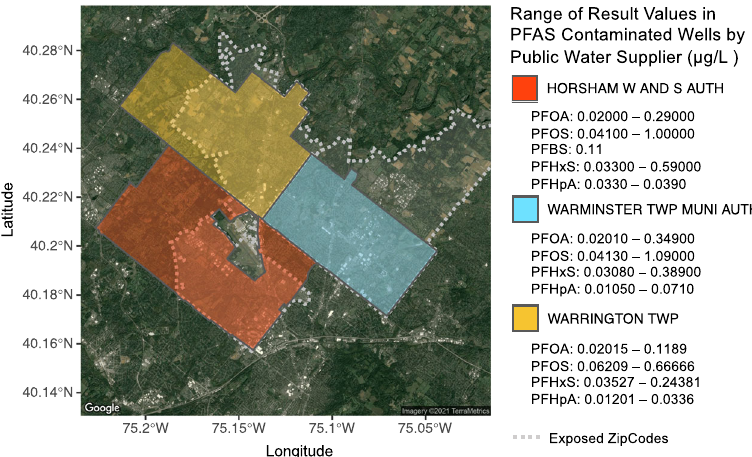
Fig. 4 PFAS exposure levels as reported in public water utilities. Results over the minimum reporting level (MRL) de fi ned by UCMR-3 are recorded in μ g/L and null values indicate results less than the MRL. The MRL for each contaminant is as follows: PFOS (0.02), PFOA (0.04), PFBS (0.09), PFNA (0.02), PFHxS (0.03), and PFHpA (0.01). In all three public water systems, PFOS, PFOA, PFHxS and PFHpA were detected over the MRL. PFBS was solely detected above MRL in Horsham Water and Sewer Authority, while PFNA was not detectable above MRL in any of the three systems. Corresponding ZIP code boundaries are shown with gray-dashed bordering. The underlying base map is generated from the R package ggmap that uses a map from Maps Static API provided by Google Maps Platform. Additional layers and annotation provided by